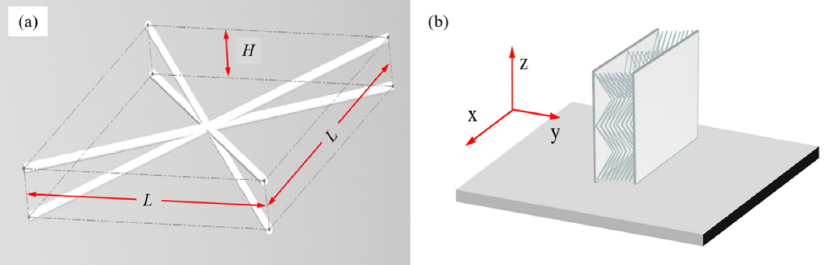
Figure 1. Design and 3D printing of the BWR lattice. ( a ) Core of the BWR lattice; ( b ) Vertical placement for specimen. Table 1. Parameters of the BWR lattices.